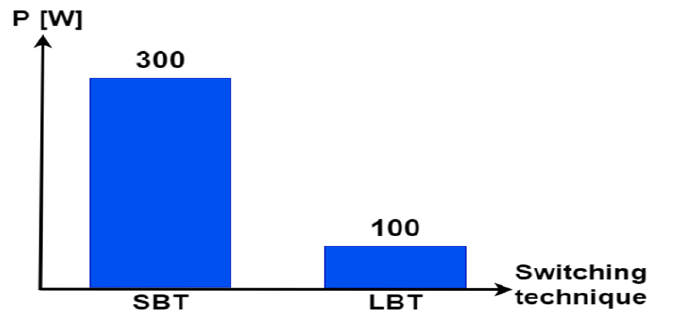
Figure 21. HEV power ripples SBT vs. LBT.